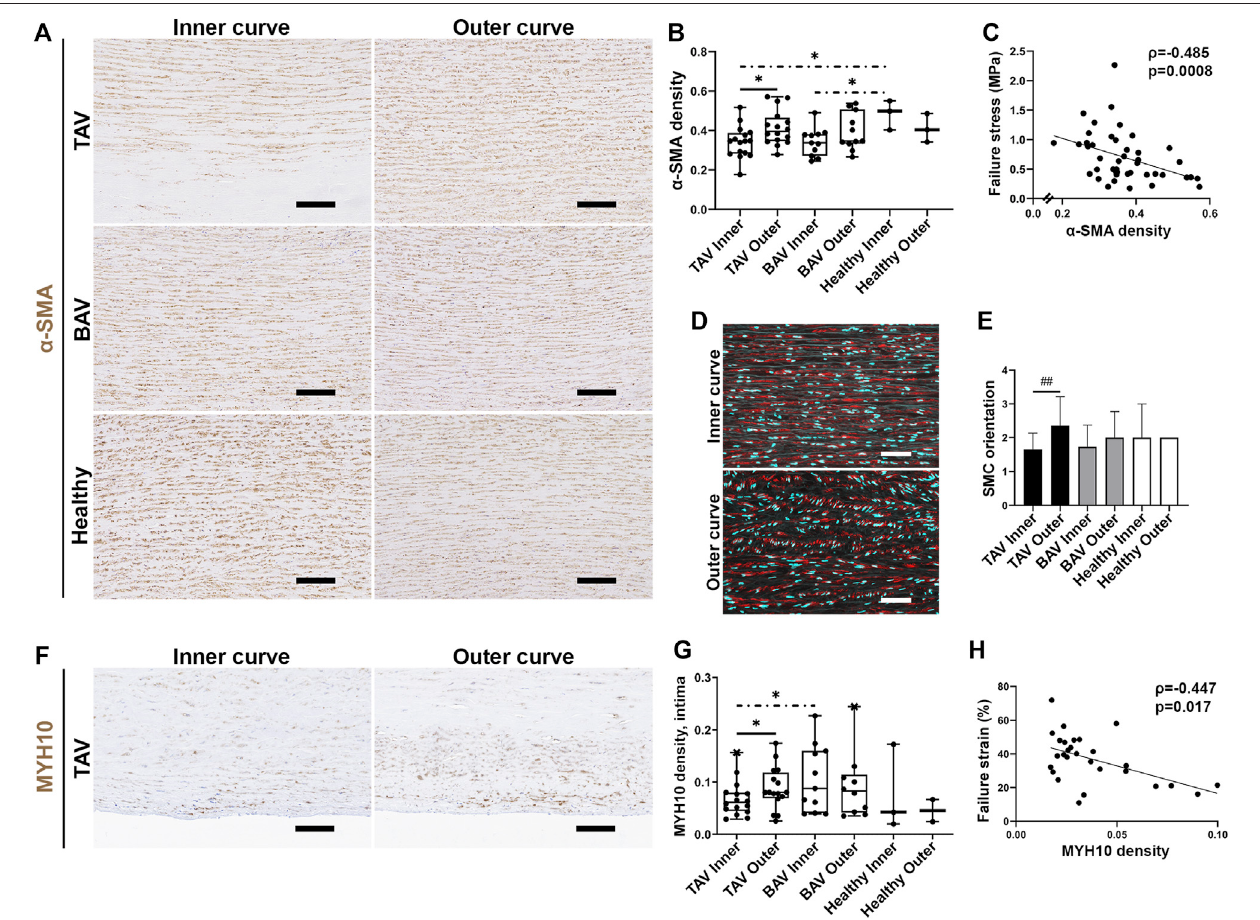
FIGURE5|(A) RepresentativeimagesofcontractileSMCsintheinnerandoutercurves.Scalebars,200 µm. (B) Thedensity of α -SMA + cellswasincreasedinthe outer curves in TAV patients. α -SMA density was higher in the inner curves of healthy aortas compared to patients with TAA. (C) Correlation was detected between α - SMA density and failure stress in all patients with TAA. (D) Representative images of SMC orientation in the inner and outer curves in TAV patients (red, α -SMA; cyan, DAPI-labelednuclei).Scalebars,100 µm. (E) SMCorientationwaschangedfromlineartorandomintheoutercurvesinTAVpatients. (F) Representativeimagesof MYH10 staining in TAV patients. Scale bars, 100 µm. (G) MYH10 density was increased in the intimal layer of the outer curves in TAV patients. (H) Correlation was detectedbetweenMYH10densityandfailurestraininTAVpatients. p -values < *0.05, < **0.01.Asterisk:parametrictest,hashsign:non-parametrictest,solidline:paired experiment, dot-dash line: unpaired